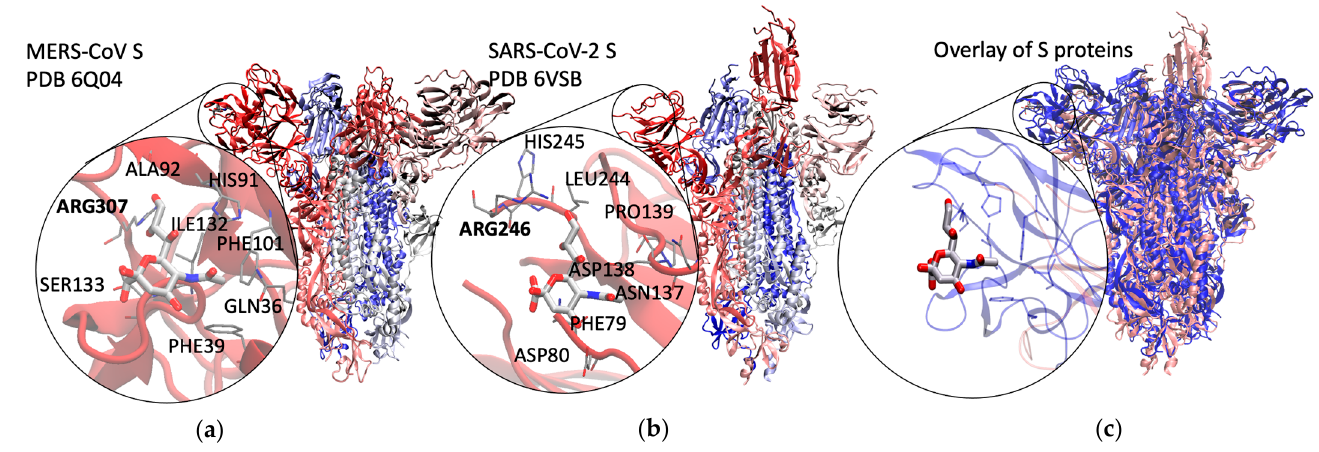
Figure 2. Binding pose in SARS-CoV-2 S protein based on MERS-CoV S protein. ( a ) MERS-CoV S protein with Neu5Ac bound, cryo-EM structure; ( b ) initial binding pose of Neu5Ac in SARS-CoV-2 S protein based on MERS-CoV S protein, used as a starting point for MD simulations; ( c ) structural overlay of pink SARS-CoV-2 S protein (PDB ID: 6VSB) with blue MERS-CoV S protein in complex with Neu5Ac, highlighting binding residues from MERS-CoV S protein (PDB ID: 6Q04).